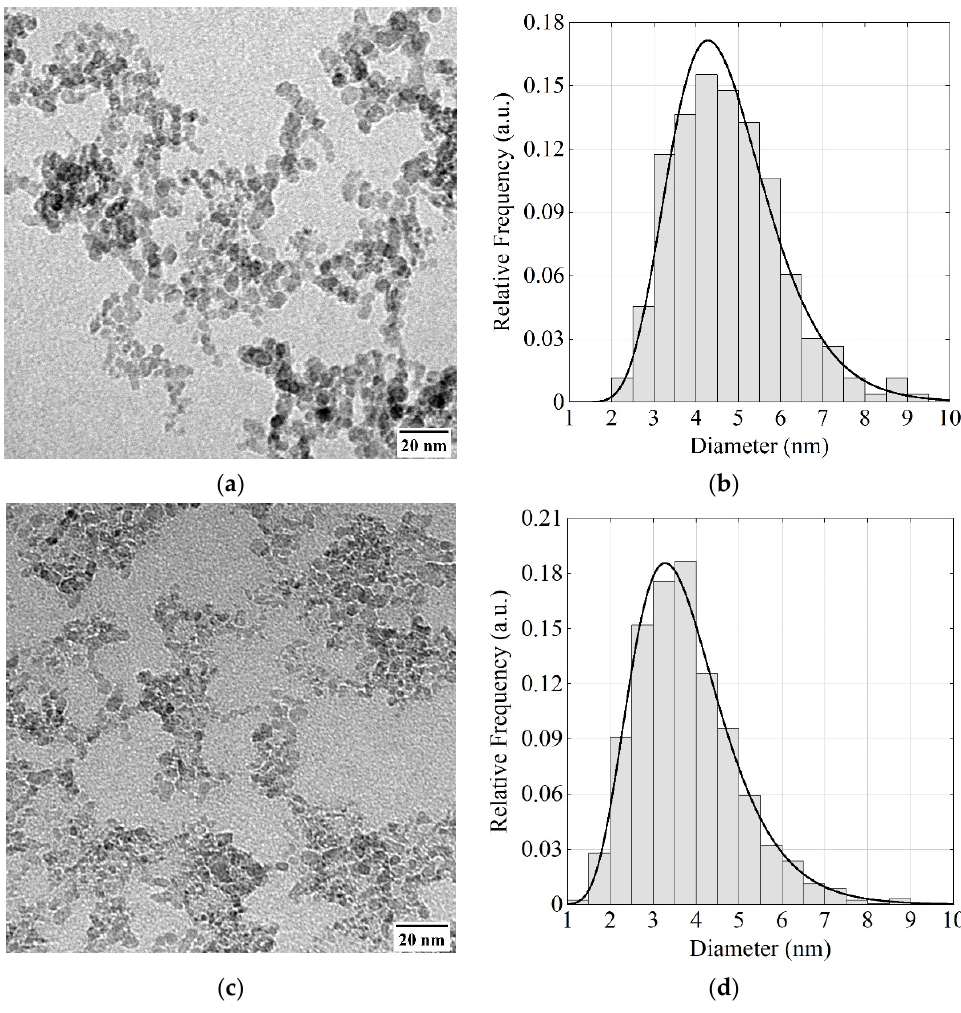
Figure 2. ( a , c ) Examples of TEM images of the DF-DND and S-DND samples; ( b , d ) size distributions for DF-DNDs and S-DNDs evaluated using all TEM images available.